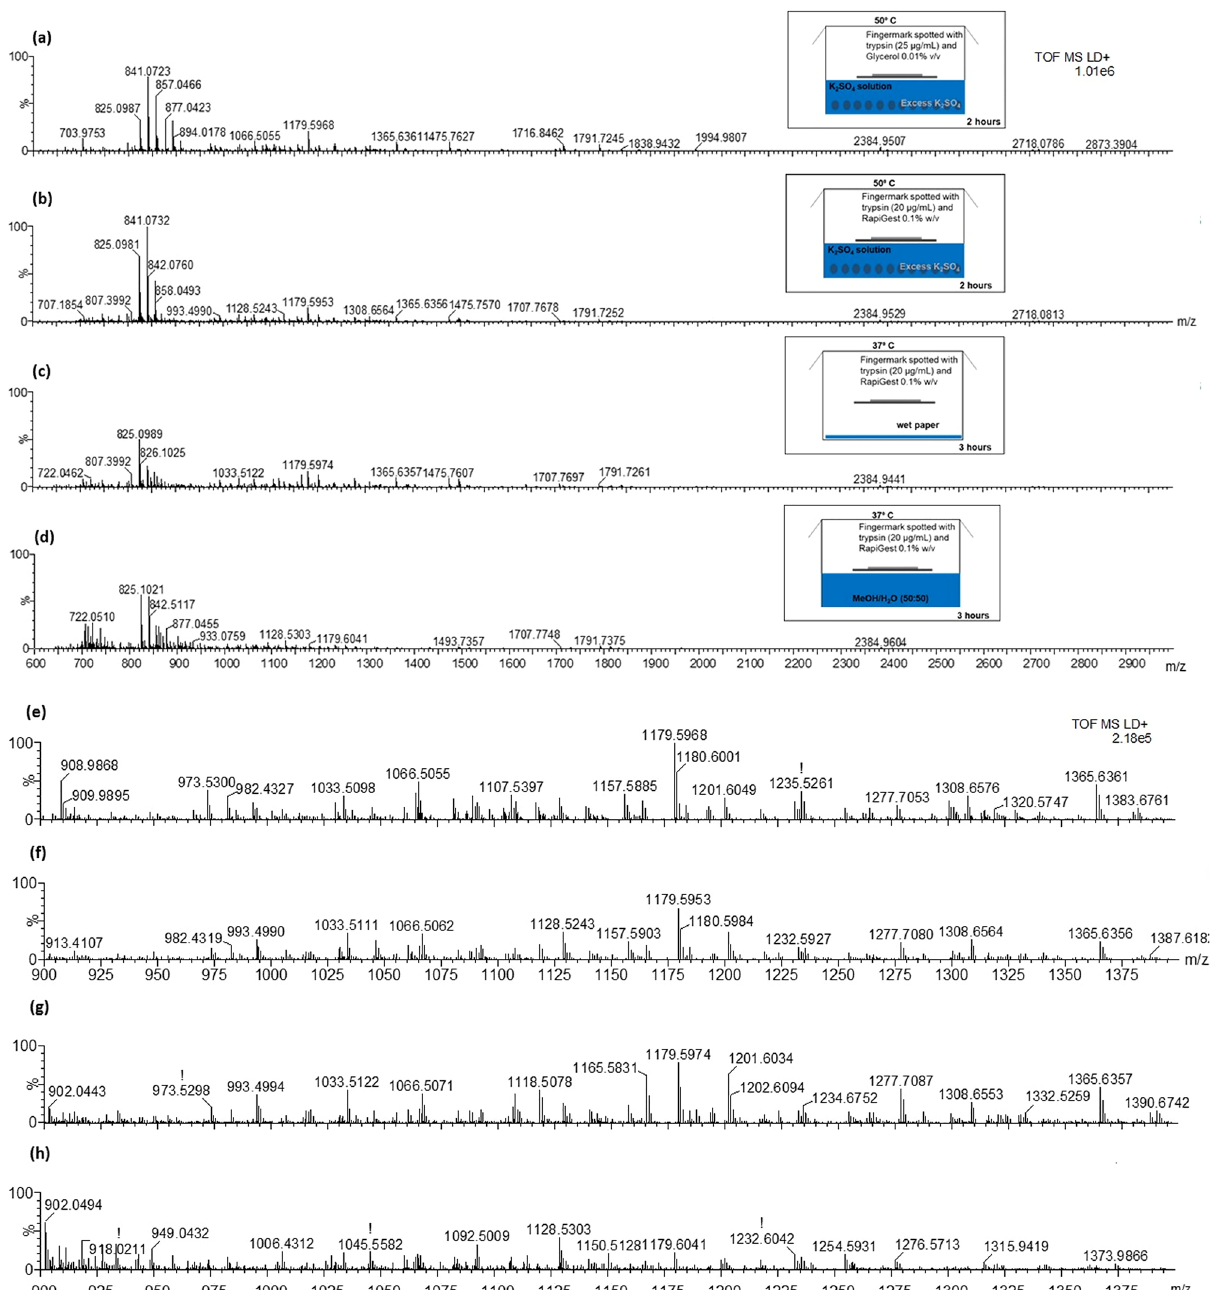
Figure 1. MALDI MS peptide spectra from in situ digests of ungroomed fingermarks trialled using four sets of different conditions. Panel ( a )— set (i): fingermark spotted with 25 µg/mL trypsin containing 0.01% v/v glycerol and incubated in a Tupperware box containing saturated K 2 SO 4 solution at 50 °C for 2 h; panel ( b )— set (ii) : fingermark spotted using set (i) conditions except for trypsin used at a concentration of 20 μg/mL and RapiGest SF at 0.1% replacing glycerol; panel ( c )— set (iii) fingermark spotted using 20 μg/mL trypsin containing 0.1% RapiGest SF and incubated at 37 °C for 3 h in a Tupperware box containing water-wet paper; panel ( d )— set (iv) : fingermark spotted using same conditions as set (iii) but replacing the wet paper with 50:50 H 2 O:MeOH solution. Panels ( e–h ) show a zoom in the m/z region between 900–1400 for the spectra in the panels ( a – d )